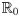
Sensitivity indices of R0 changing with the fraction of people exposed to mosquitoes, π, ranging from 0 to 1.(a) Sensitivity indices of R0 for DENV transmitted by Ae. aegypti mosquitoes. (b) Sensitivity indices of R0 for DENV transmitted by Ae. albopitus mosquitoes. (c) Sensitivity indices of R0 for CHIKV transmitted by Ae. aegypti mosquitoes. (d) Sensitivity indices of R0 for CHIKV transmitted by Ae. albopictus mosquitoes. (e) Sensitivity indices of R0 for ZIKV transmitted by Ae. aegypti mosquitoes. (f) Sensitivity indices of R0 for ZIKV transmitted by Ae. albopictus mosquitoes.